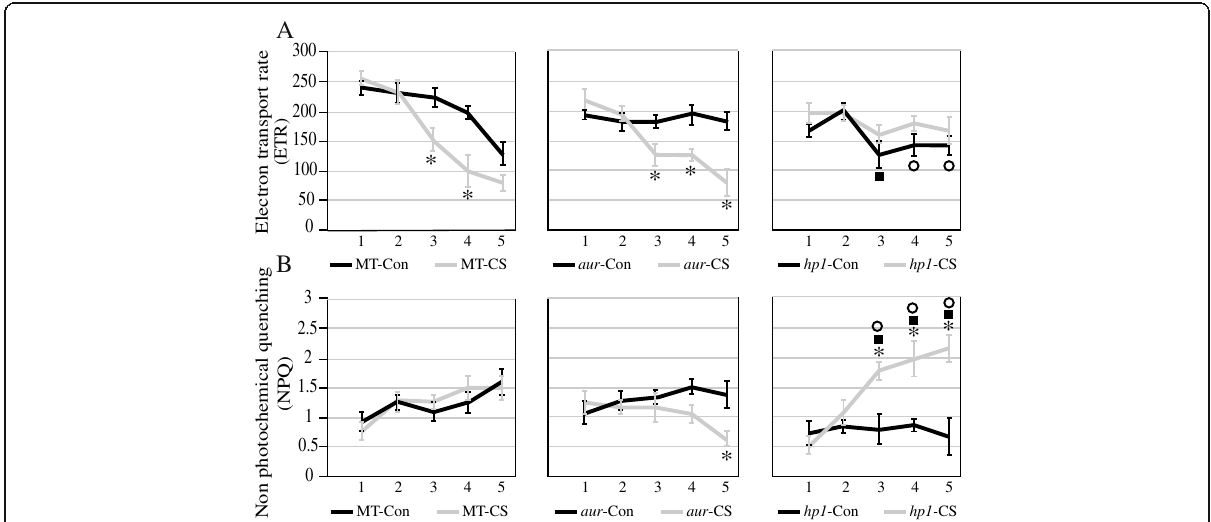
Fig. 4 Effect of chilling stress on a electron transport rate (ETR) and b non-photochemical quenching (NPQ) in all three tomato genotypes under control (Con) and chilling stress (CS). Blue lines represent data for control and green lines show data for stress treatment. Symbols that are not similar show significant differences (calculated by Tukey ’ s test, P < 0.05). Comparisons between the control and stress treatments within the same genotype were indicated as asterisks, whereas solid squares represent comparisons among genotypes under the control treatment and circles were used for comparisons among genotypes under the stress